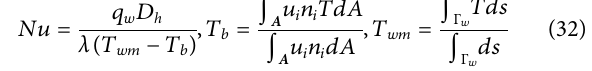
TABLE 5 | Correlations of Nusselt number for the square bundle. Investigator Correlation